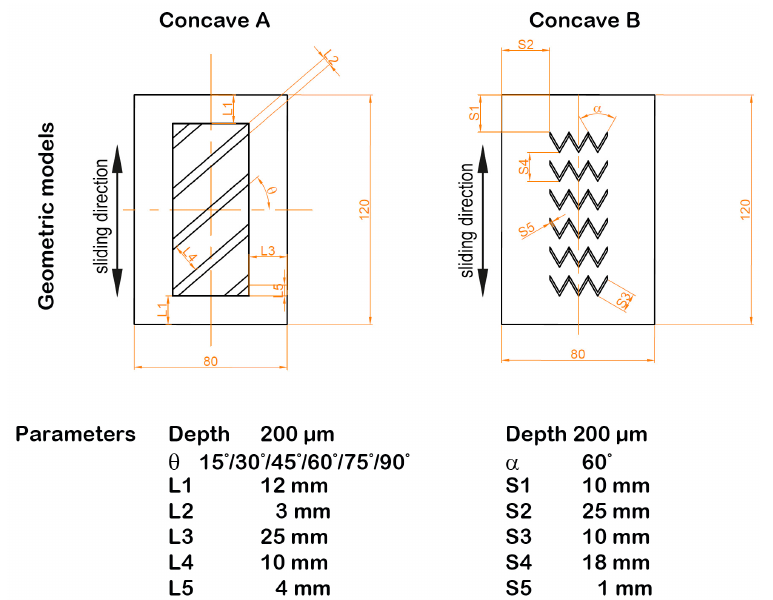
Figure 9. Textured surfaces used in [81].